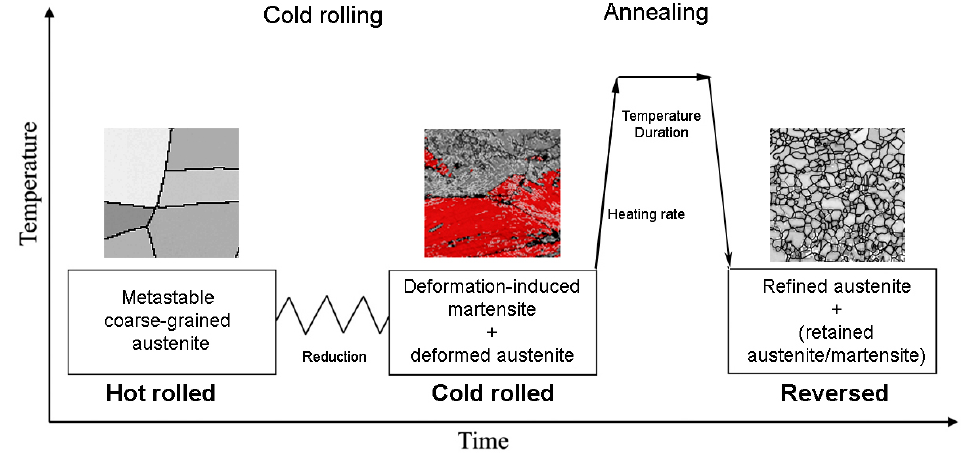
Figure 1. Reversion treatment of a metastable austenitic stainless-steel consisting of cold rolling and annealing stages. Important variables have been designated.